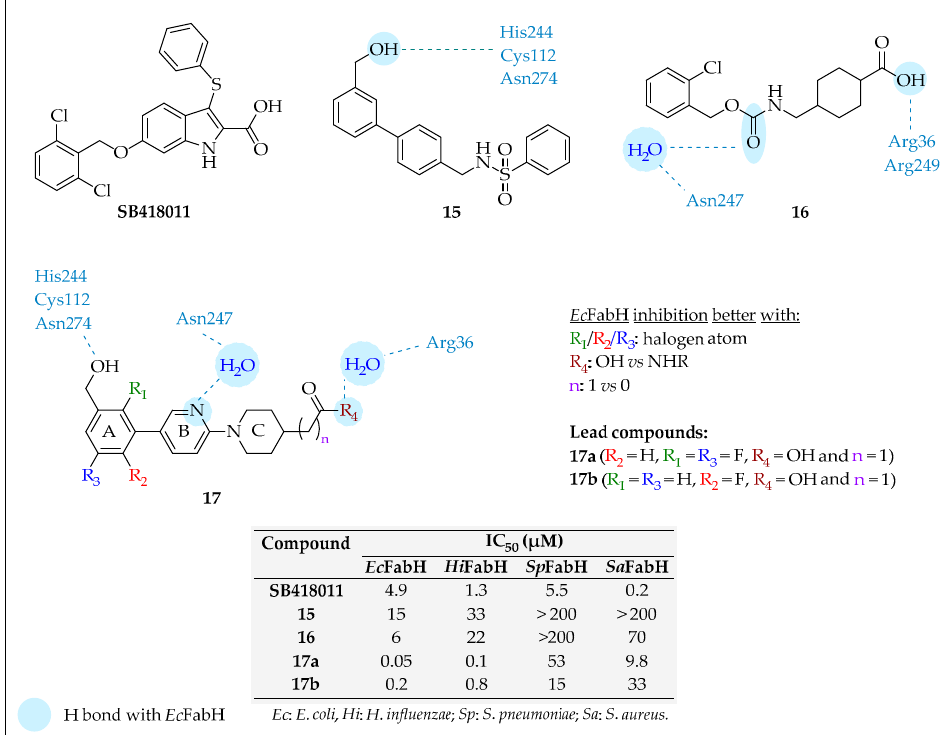
Figure 14. Structures and representation of main interactions with Ec FabH of SB414011 , 15–17 and in vitro activities of lead compounds [36,86]. in vitro activities of lead compounds